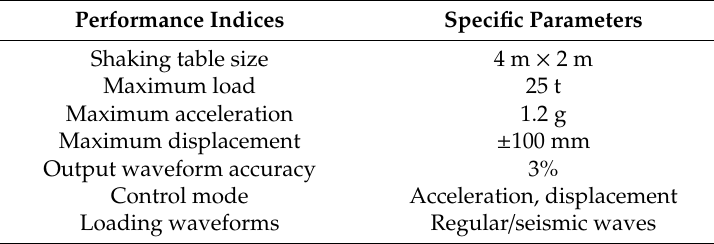
Table 1. Operation parameters of the shaking Figure 3. Diagrams of shaking table and rigid model box. ( a ) Shaking table; ( b ) rigid model box.